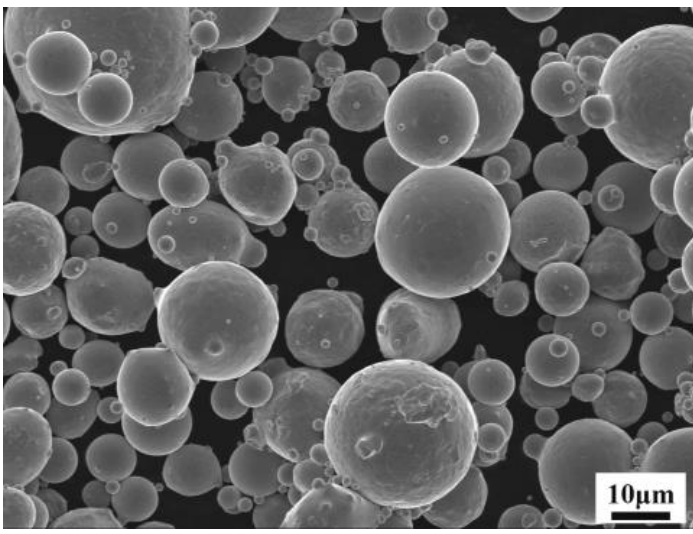
Figure 2. SEM image of CuCrZr powder.